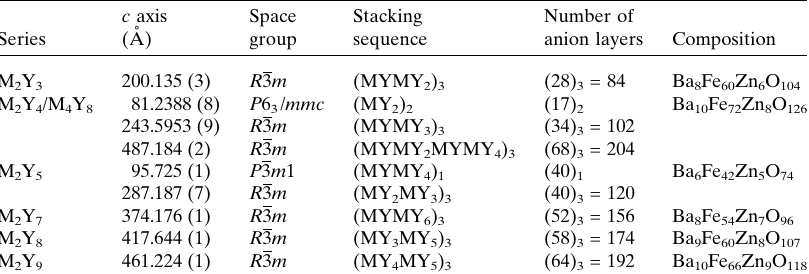
Table 4 Summary of the synthesized mixed-layer